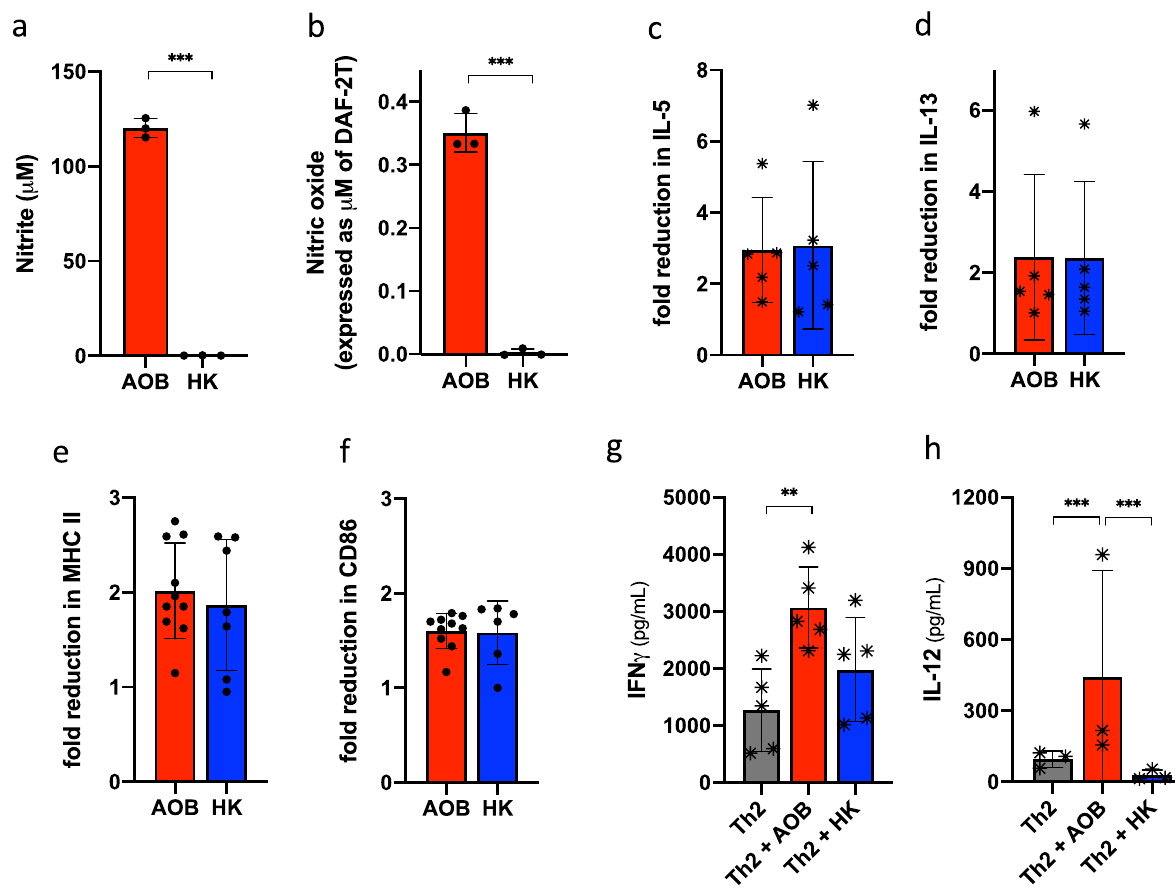
Figure 4. Structural components could be responsible for AOB-mediated Th2 inhibition. ( a , b ) AOB metabolites nitrite ( a ) and nitric oxide ( b ) are produced by live but not heat killed AOB after 1 h incubation in AOB culture media (n = 3, unpaired t-test). ( c , d ) Fold-reduction in IL-5 ( c ) and IL-13 ( d ) mediated by AOB (red) is not significantly different from fold-reduction mediated by heat killed AOB (blue); measured by ELISA in cell culture supernatant collected 72 h post-stimulation with the Th2 stimulation cocktail (n ≥ 6 per donor, 5 donors, one datapoint per donor, unpaired T test). ( e , f ) Fold reduction in MHC II ( e ) and CD86 ( f ) expression in CD11c+ cells mediated by live AOB (red) is not significantly different from fold-reduction mediated by heat killed AOB (blue); measured by flow cytometry 72 h after Th2 stimulation in donor C (n = 6, unpaired T test). ( g , h ) IFNγ ( g ) and IL-12p70 ( h ) production by PBMC are not as strongly induced by heat killed AOB (blue) as by live AOB (red); measured by ELISA from supernatant of PBMC culture collected 72 h post-stimulation (n ≥